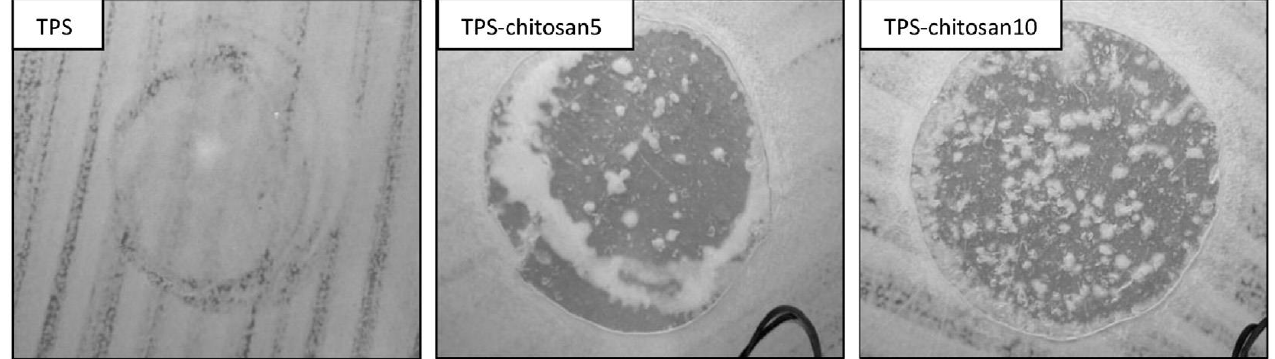
Figure 6. Improvement in the corn starch films morphology after adding chitosan. Reprinted with permission from Ref [145], copyright 2022, Springer Nature.